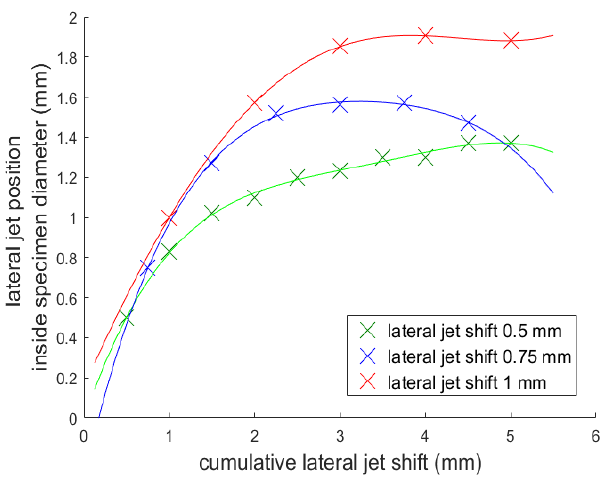
Figure 8. Cumulative lateral jet shift; comparison of the lateral position inside the specimen diameter.